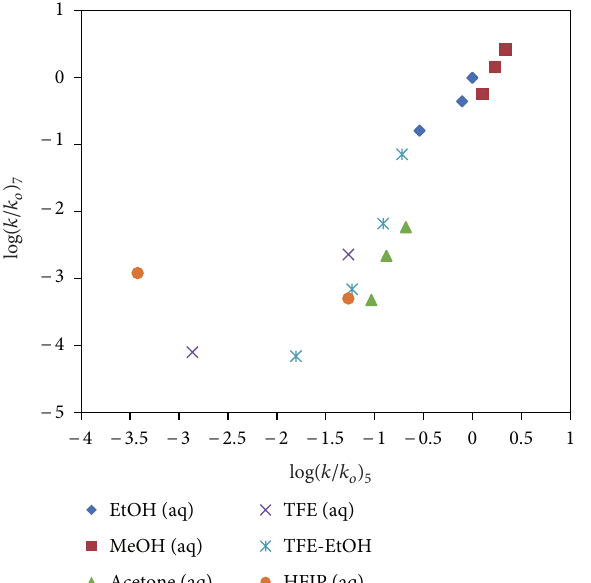
F 4: e plot of log formate ( 7 ) against log the seventeen common pure and binary solvents studied.